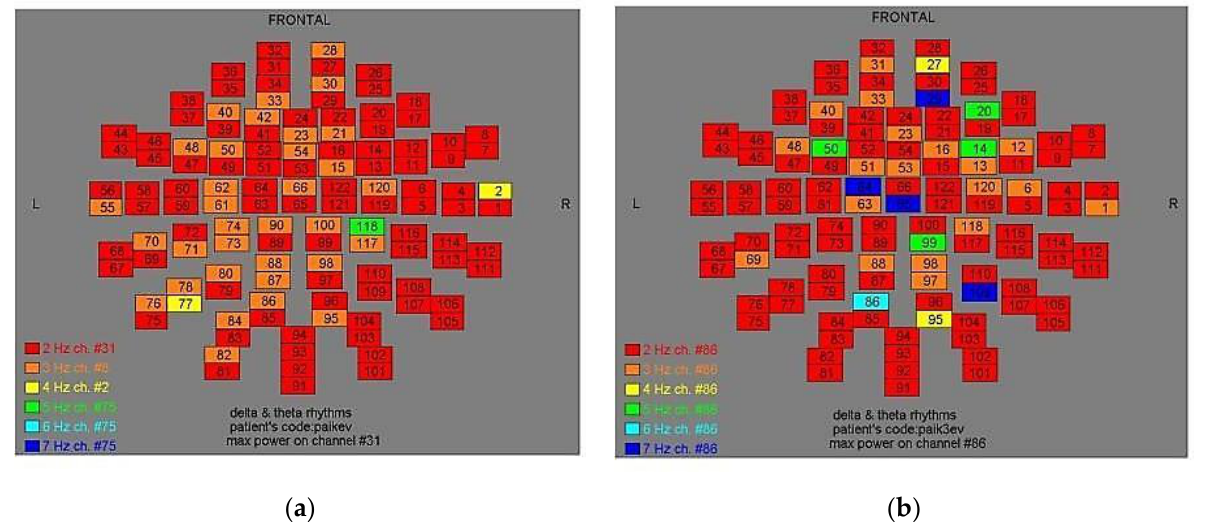
Figure 2. Dominant frequency color mapping for patient #1, before ( a ) and after ( b ) magnetic stimulation.